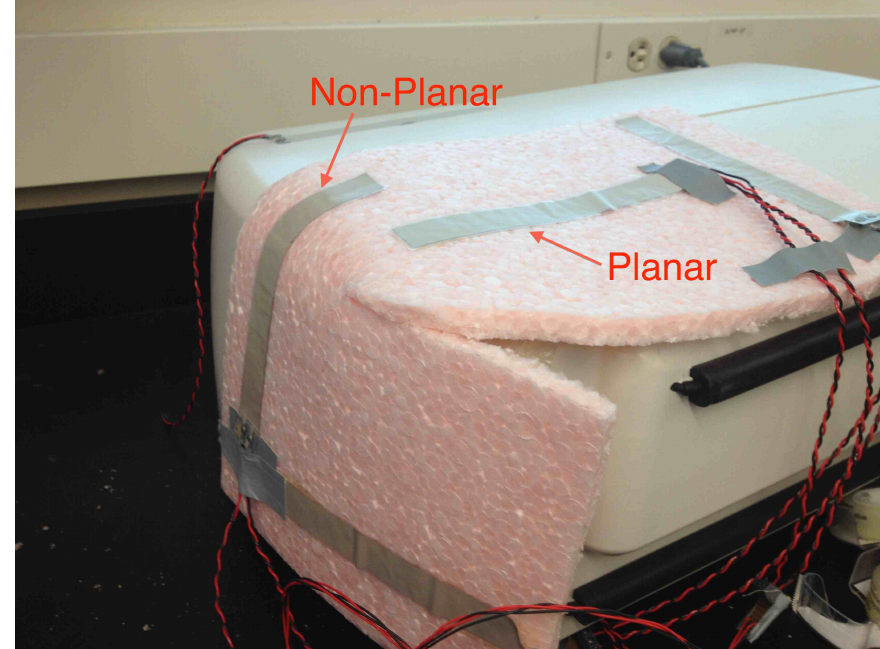
Figure 3. Sensor prototype used in testing showing planar (top of cover) and non-planar (rounded left end) sensor applications on example robotic arm shielding. Wires in picture connect sensor electrodes to